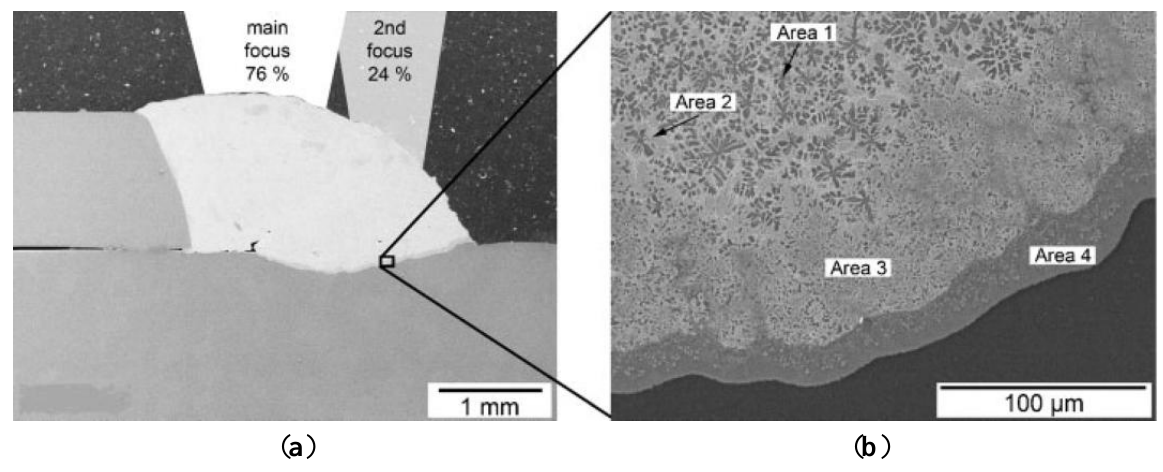
Figure 8. Cross-section and microstructures of laser welded joint with ZnAl15 [56]. ( a ) Overview; ( b ) detail of intermetallic phase seam